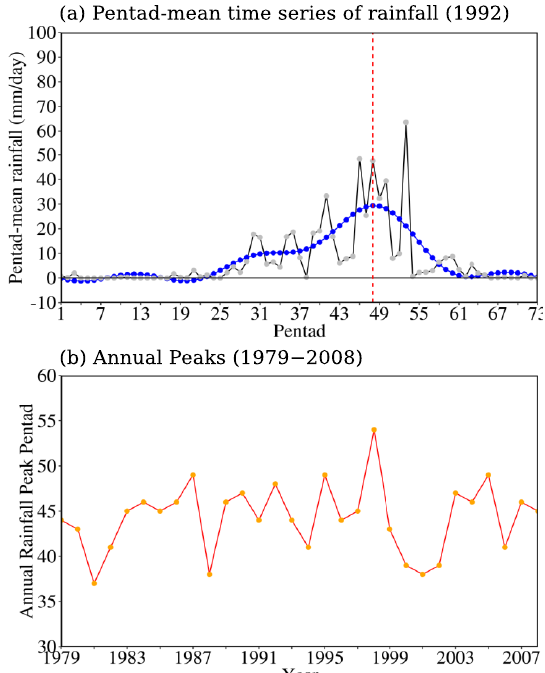
Figure 4. ( a ) Pentad-mean rainfall time series for a typical year (1992; black line; mm day − 1 ) and its equivalent smoothed time series (blue line) obtained by adding the first four Fourier harmonics of the original time series; and ( b ) time series of annual peak pentads, defined as the maximum of the smoothed time series, from 1979 to 2008.